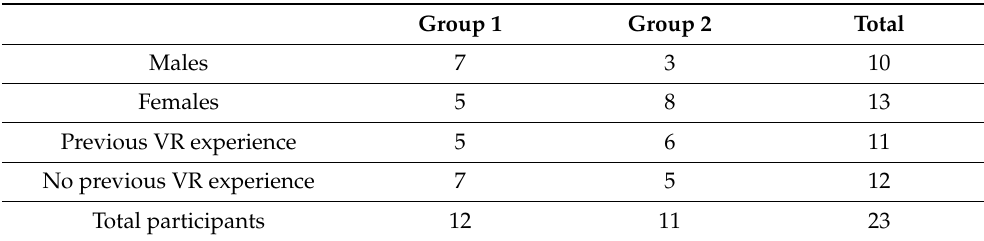
Table 4. Experiment participants and previous VR experience.